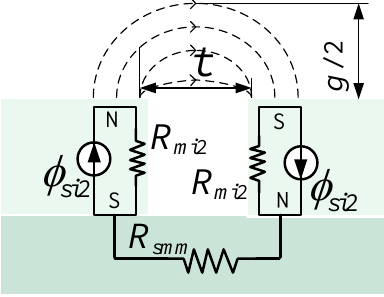
Figure 10. The flux leakage model of the inner